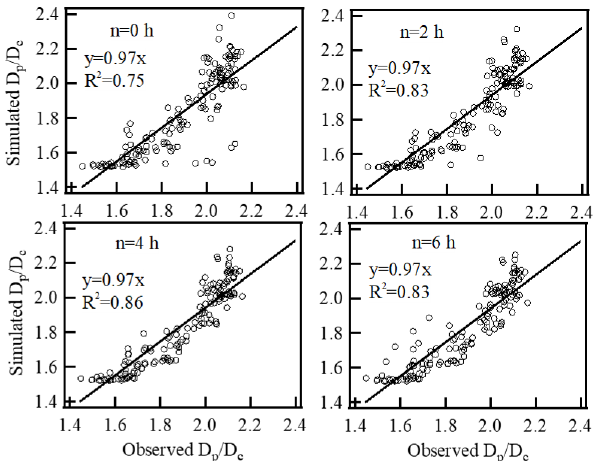
Figure 5. Comparison of the hourly D p /D c ratio of BC between the model simulations and observations at our site with different n values in Eq. (13) on 24–30 November 2014 at the Tsinghua